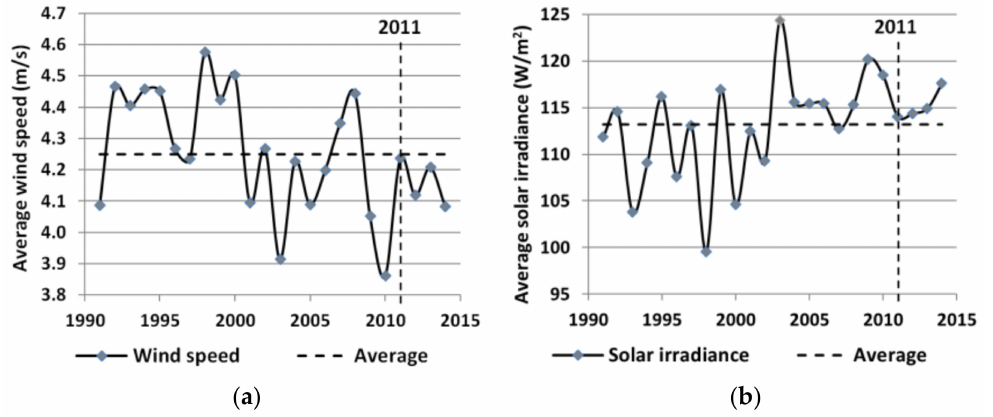
Figure 3. ( a ) Average year for cumulative wind speed, ( b ) Average year for cumulative solar